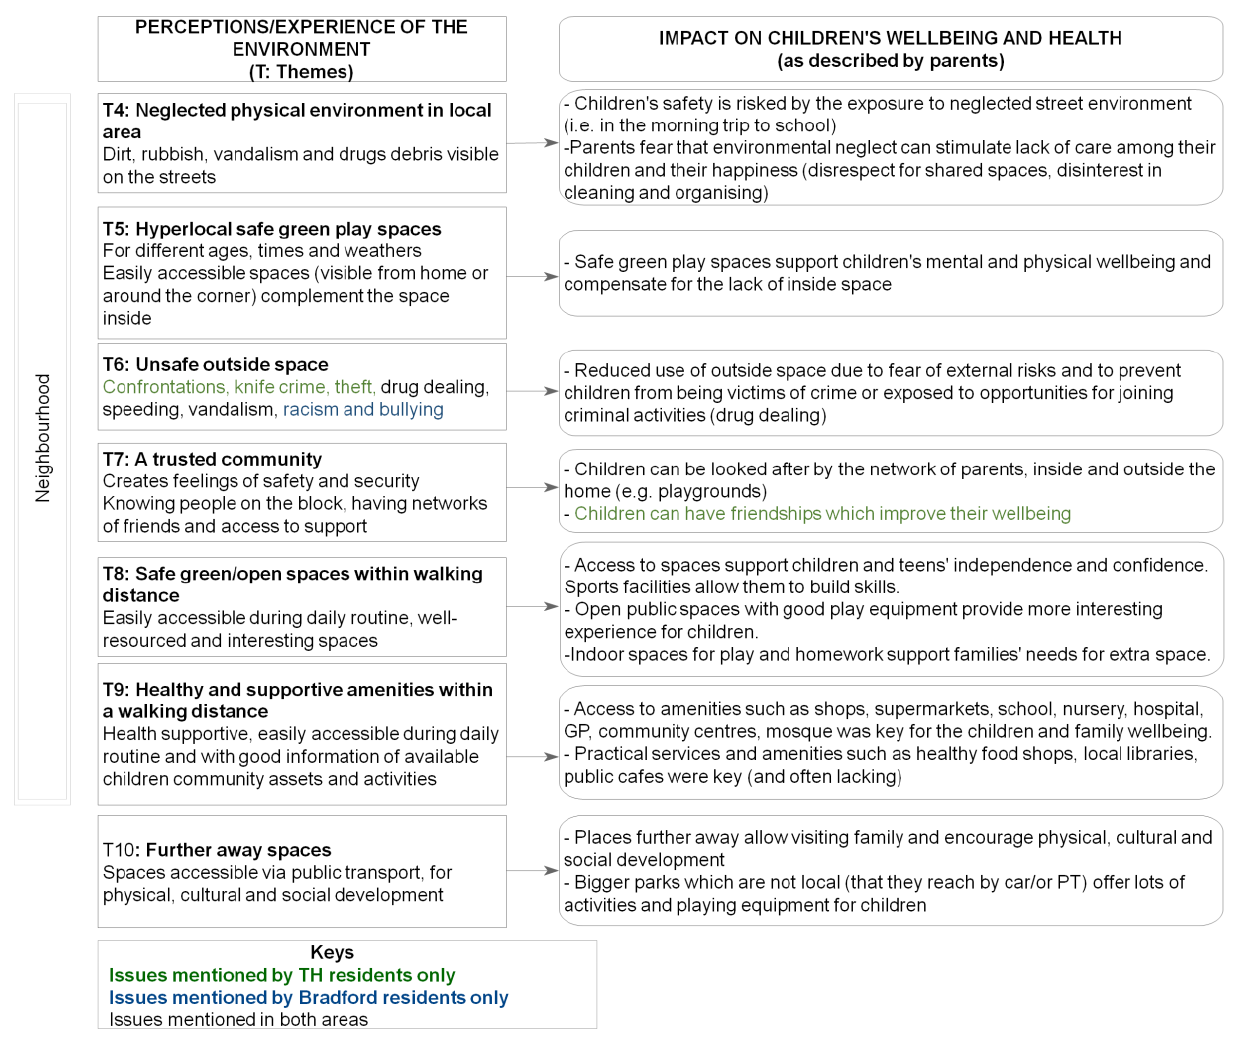
Figure 4. Neighbourhood themes and